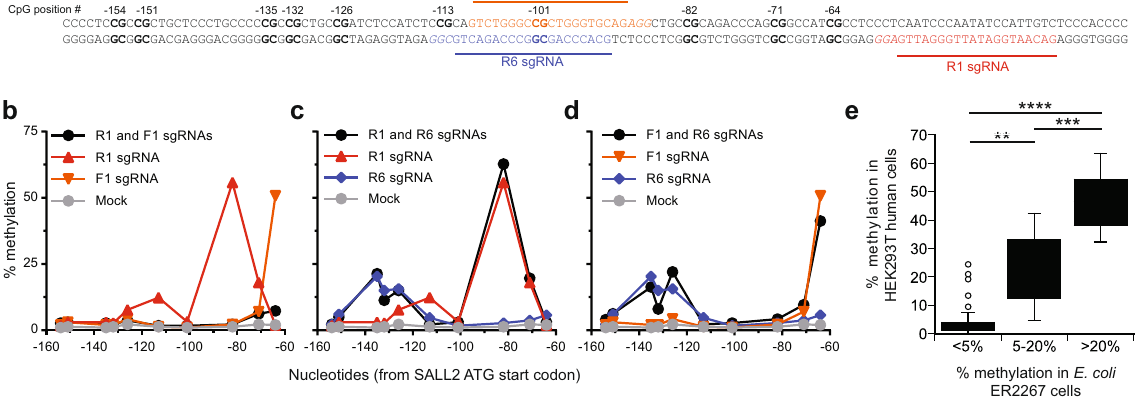
Figure 5. sgRNA design rules for targeted methylation in HEK293T cells. ( a ) Nucleotide sequence relative to the translation start site of the SALL2 P2 promoter showing locations of CpG sites (bold) and sgRNA sequences and PAM sequences (italics). ( b – d ) Representative pyrosequencing data showing the percent methylation in the SALL2 promoter in HEK293T cells cotransfected with pCMV-sMTase and either one sgRNA (color coded) or two sgRNAs (black circle). Data shown is from a single representative experiment. Identical trends for all combinations were observed in a replicate experiment. ( e ) Correlation between methylation in HEK293T cells and E. coli ER2267 cells at equivalent gap lengths. Percent methylation in E. coli as a function of gap length (Fig. 2a) were classified as low ( < 5%), medium (5–20%) and high ( > 20%) and the mean and distribution of the corresponding percent methylation values in HEK293T cells were compared by Student’s t -test. ****